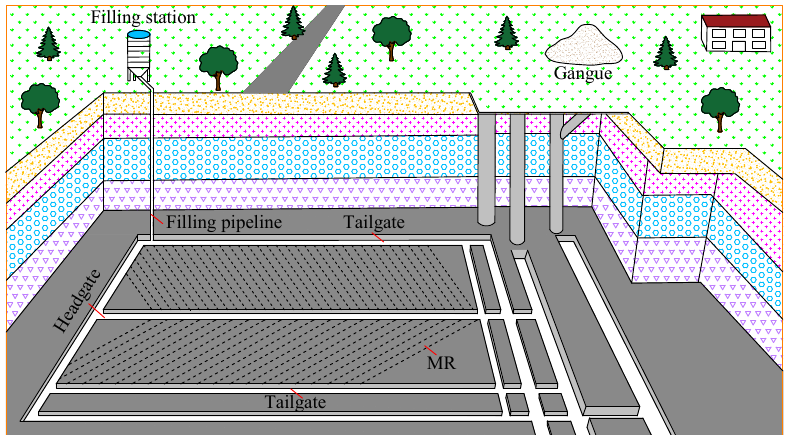
Figure 1. Three-dimensional sketch map of the MR arrangement of the CECB mining method.